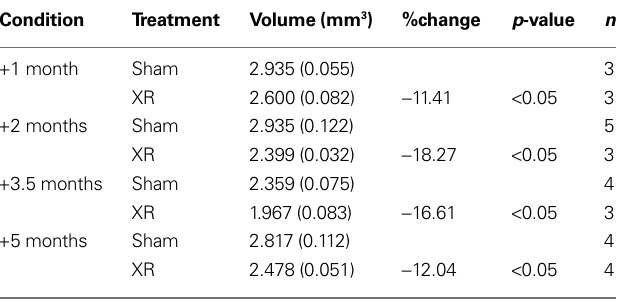
Shown is the volume encompassed by the edge of the main olfactory bulb granule cell layer. The difference between the volume of sham and x-ray (XR) treated mice is expressed as the %change of the x-ray condition from the sham condition {[(XR/Sham)-1] × 100}. Signifi cance was evaluated using a one-tailed t-test between Sham and XR mice at each time after